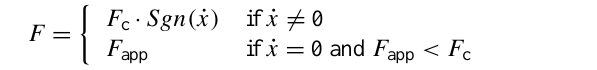
Figure 2. Friction force vs. sliding